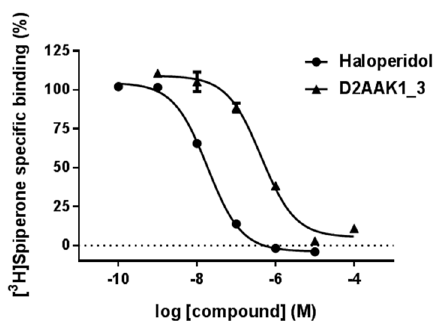
Figure 2. Competition binding curve for D2AAK1_3 at human D 2 receptors. Displacement of the specific binding of the radioligand [ 3 H]Spiperone by D2AAK1_3 in membranes from CHO-K1 cells stably expressing human cloned D 2 receptors. Haloperidol was used as the reference compound in these assays. The graph shows the results (mean ± SEM) from a single experiment representative of 2 independent experiments performed in duplicate.